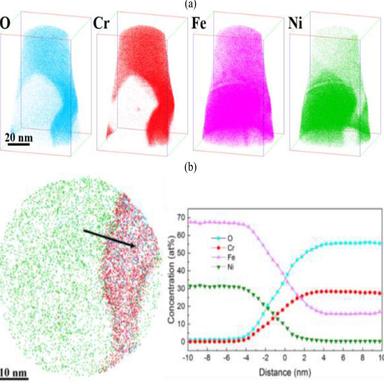
(a) APT data set showing the 3D distribution of the two phases in the inner oxide layer (Cr in red and Ni in green); (b) spatial distribution of O, Cr, Fe, and Ni in separate data sets; (c) concentration profiles across the oxide-metal phases interface.